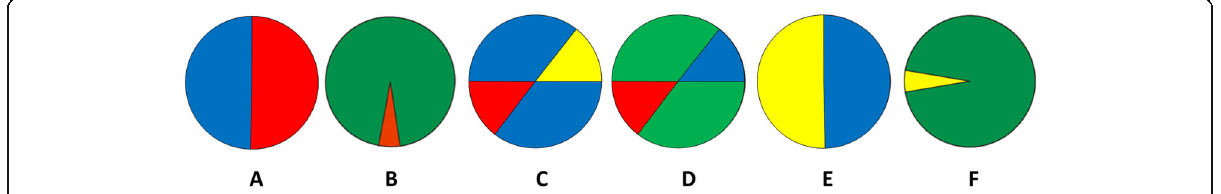
Fig. 1 Colored circles used in the test (adapted stimuli are shown because of copyright